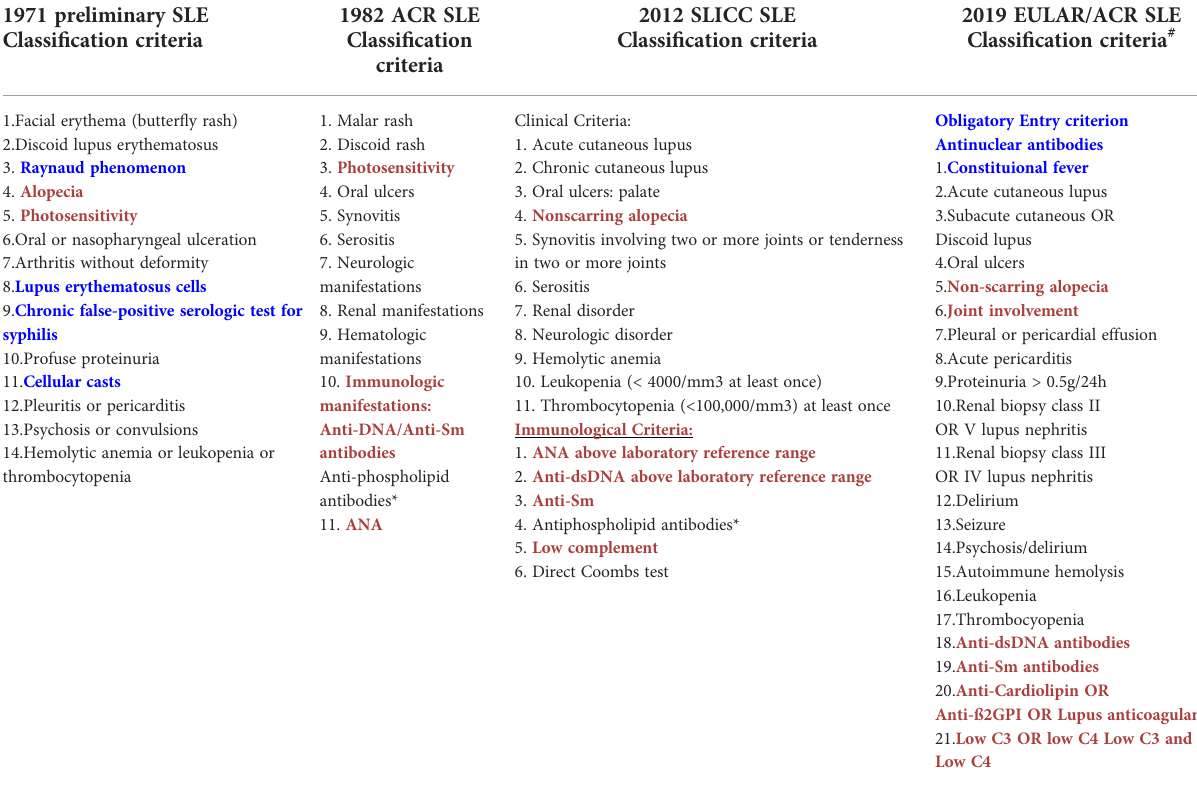
TABLE 1 Comparison* of SLE classi fi cation criteria in 4 different classi fi cation versions from